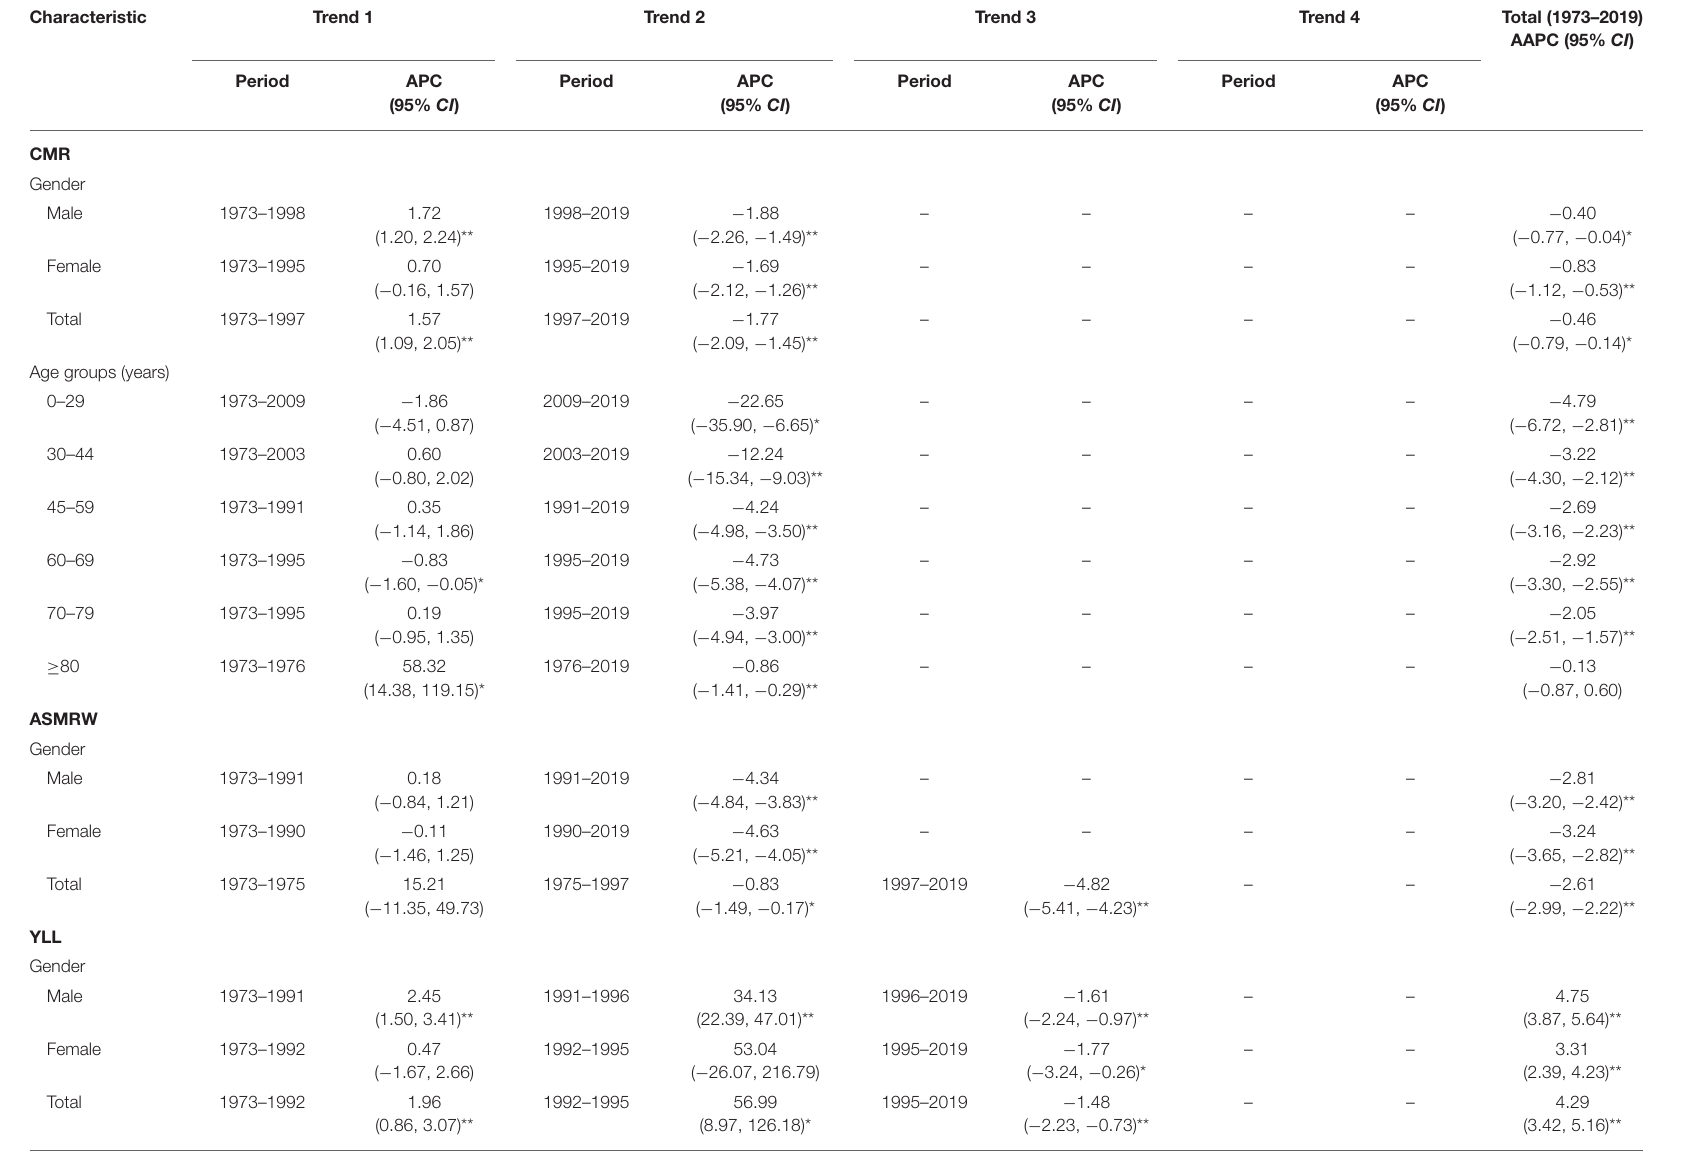
TABLE 3 | Trends of CMR, ASMRW, YLL, YLL rate of liver cancer in genders and age groups during 1973–2019. Characteristic Trend 1 Trend